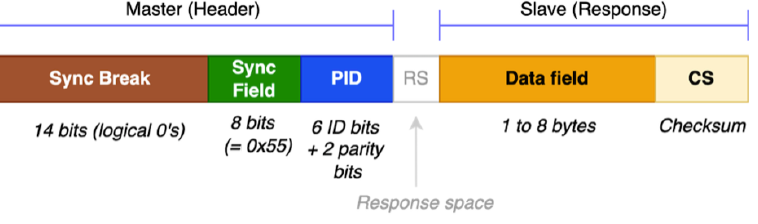
Figure 2. Details of the current, unsecured LIN message frame.